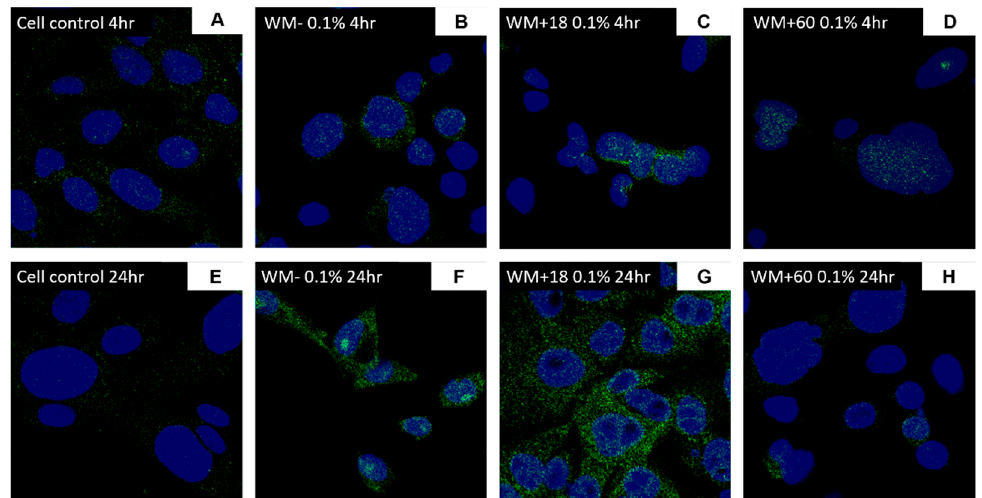
Figure 10. ACE2 protein expression of BEAS-2B cells following electronic cigarette aerosol (WM) exposure: BEAS-2B cells were exposed to a concentration (0.1%) of electronic cigarette condensate generated from watermelon e-liquid (WM) ± nicotine for 4 or 24 h. Protein expression of ACE2 was assessed through immunofluorescence staining for 4 h ( B – D ) and 24 h ( F – H ) treatments in comparison with cell controls ( A , E ). Images at 40×.